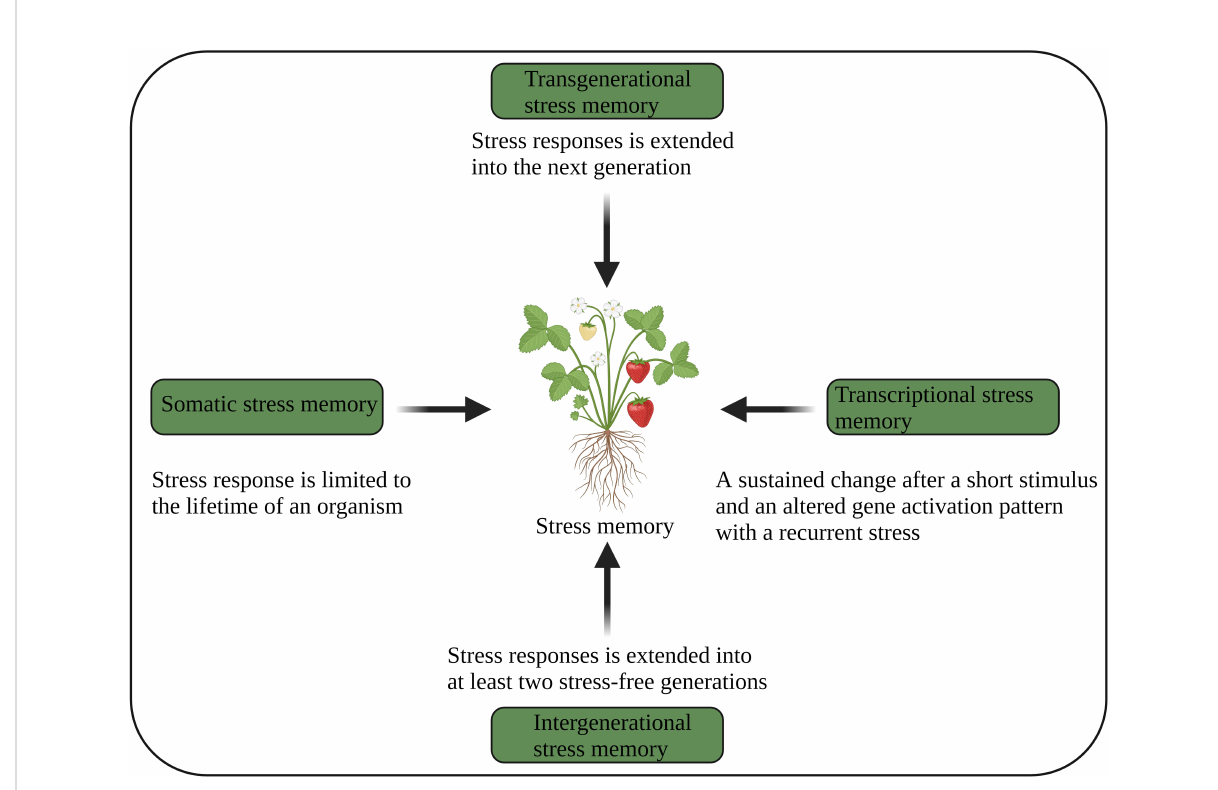
FIGURE 3 Different aspects of plant stress memory (Oberko fl er et al., 2021). The image was created using